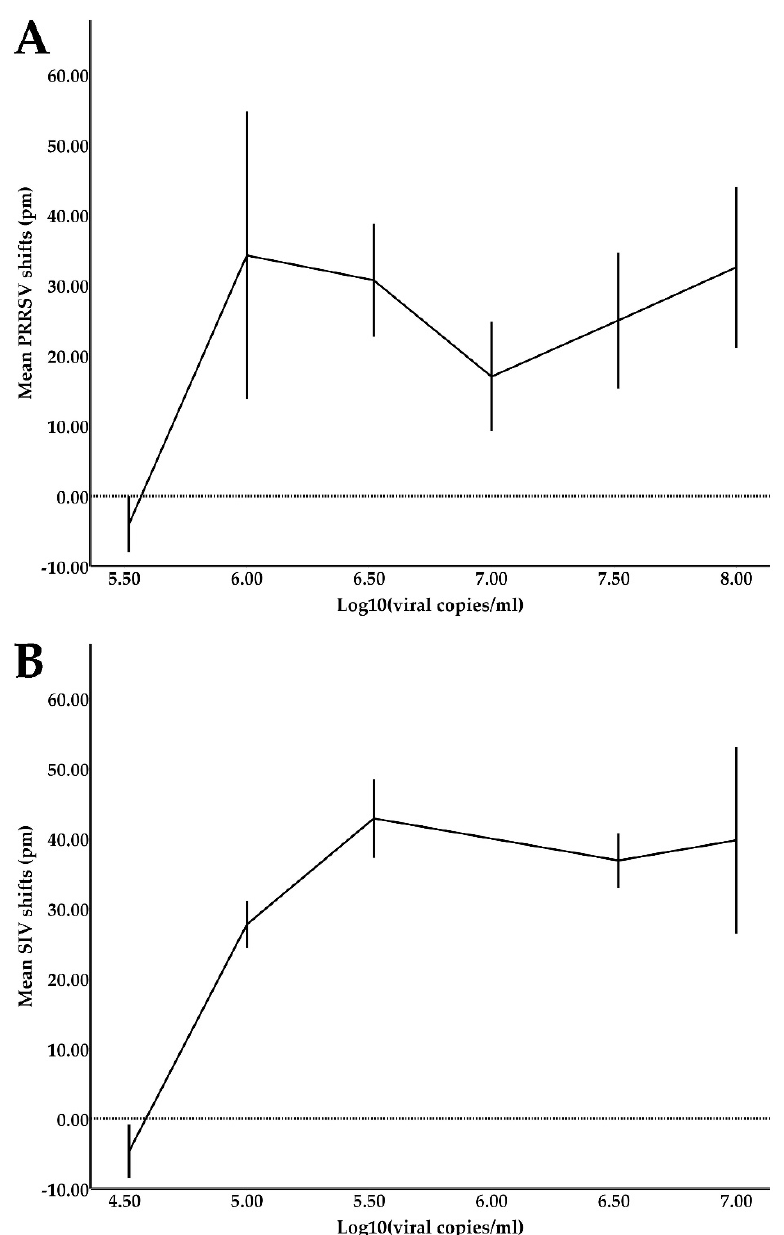
Figure 5. ( A ) PRRSV and ( B ) SIV shift responses (in pm) plotted against viral concentrations (Log10 (viral copies/mL)).